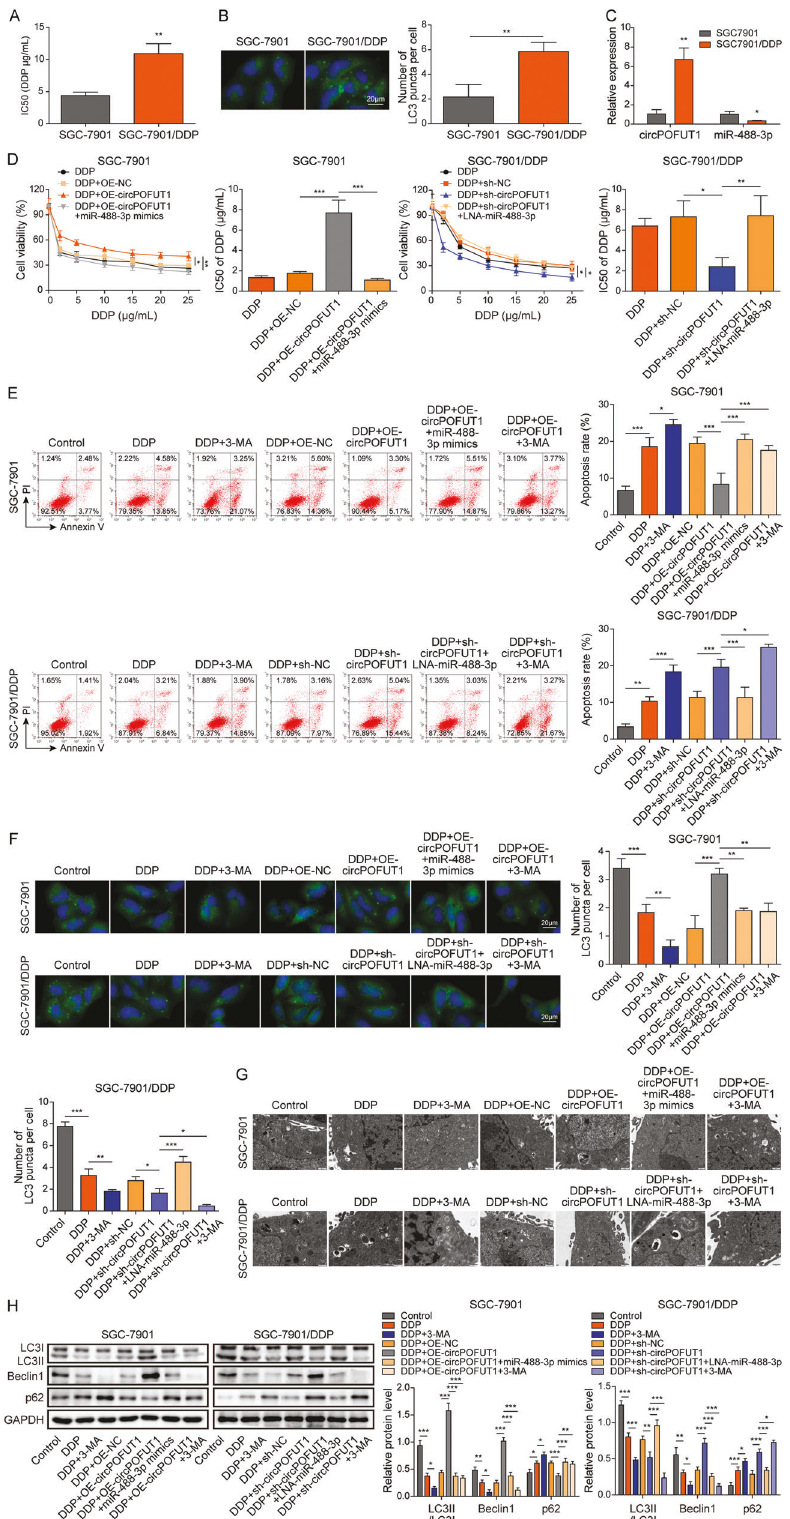
Fig. 5 CircPOFUT1 facilitated autophagy-associated chemoresistance through targeting miR-488-3p. A The IC50 of DDP ( n = 3). B IF staining of LC3 (Green; Scale bar, 20 µm; Nuclei, Blue). C The expression of circPOFUT1 and miR-488-3p ( n = 3). D Cell viability analysis after DDP treatment ( n = 3). E Cell apoptosis was examined by Annexin V and PI staining ( n = 3). F IF staining of LC3 (Green; Scale bar, 20 µm; Nuclei, Blue). G Autophagosomes were observed by electron microscope. H Protein levels of LC3II/I, Beclin1 and p62 ( n = 3). * P < 0.05, ** P < 0.01 and *** P <